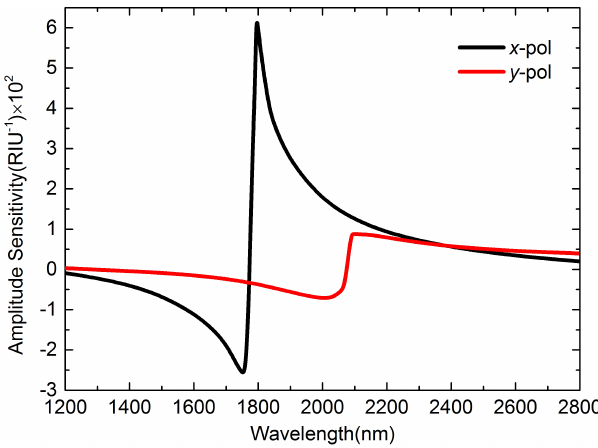
Figure 4. Amplitude sensitivities of x - and y-pol peaks when T changes form 22 ◦ C to 27 ◦ C.